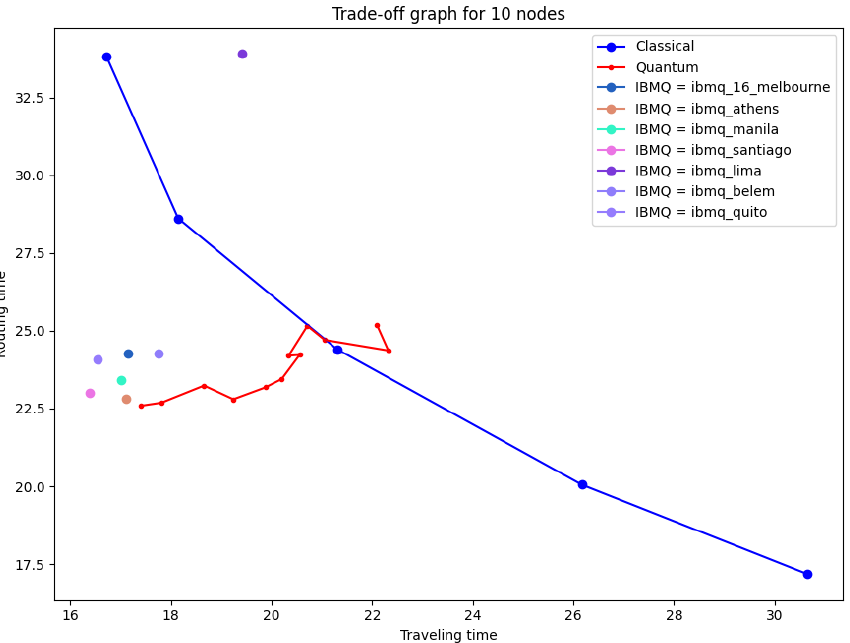
Figure 11. Effect of real devices in the trade-off barrier by quantum protocol. Congestion can be mitigated by making use of IBM NISQ quantum computers. p values between 0.3 and